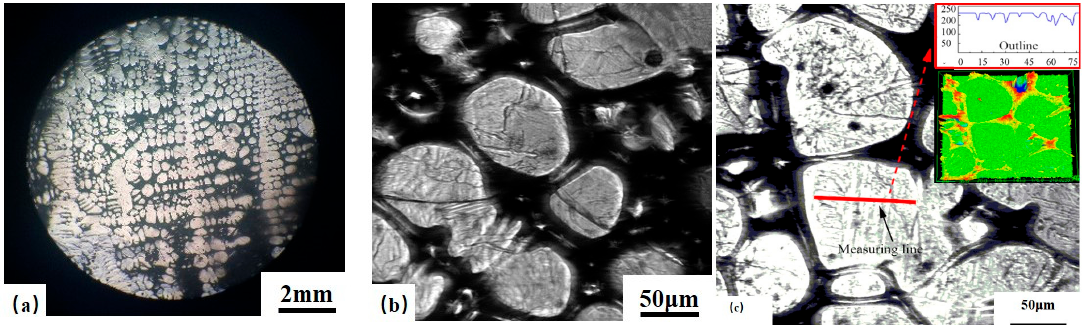
Figure 2. ( a ) the surface morphology of the sample; ( b )the surface at high magnification; ( c ) the roughness measurement process diagram.